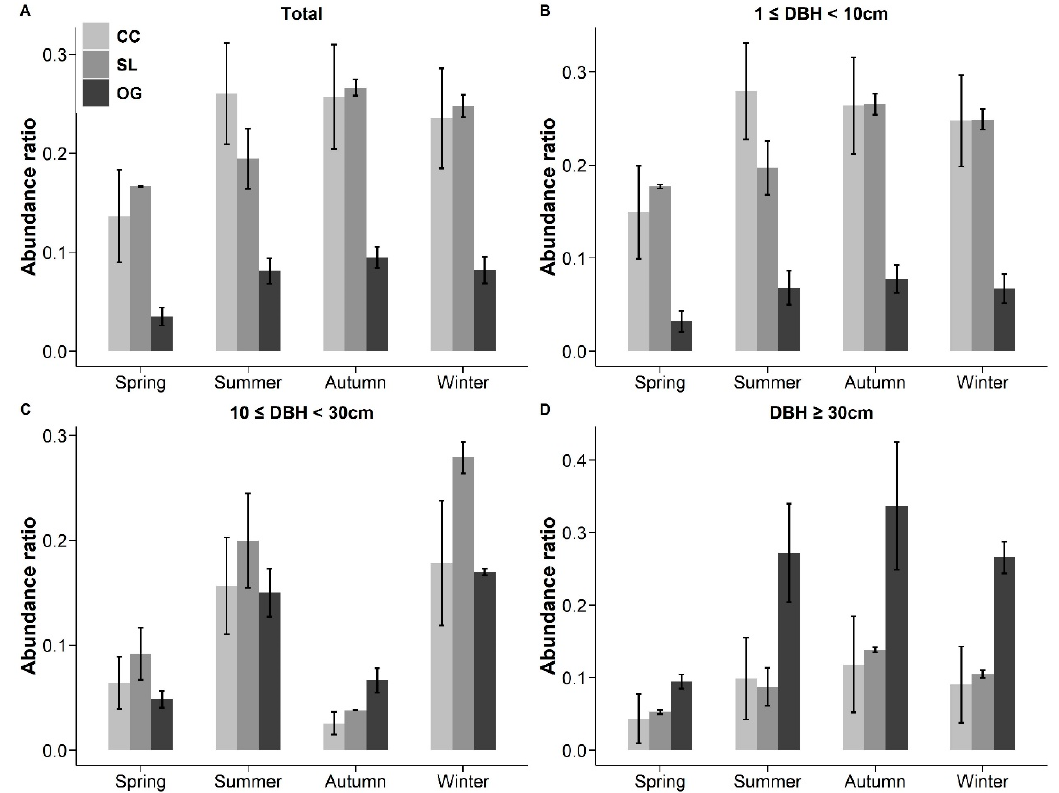
Figure 5. Distribution of abundance ratio of food plants in communities among seasons classified by phenological period of edible parts in the three forest types (clear-cutting, CC; selectively logged, SL and old-growth forest, OG) for all individuals ( A ), small trees (1 cm ≤ DBH < 10 cm, B ), medium trees (10 cm ≤ DBH < 30 cm, C ) and large trees (DBH ≥ 30 cm, D ).